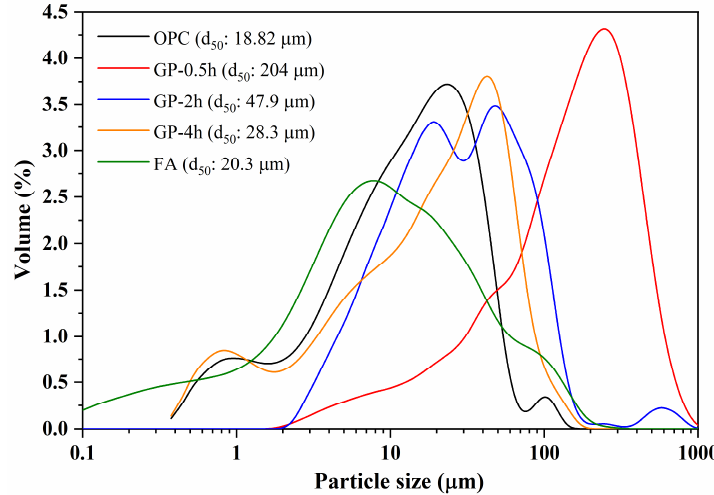
Figure 1. Particle size distributions of OPC, GP-0.5h, GP-2h, GP-4h, and FA.